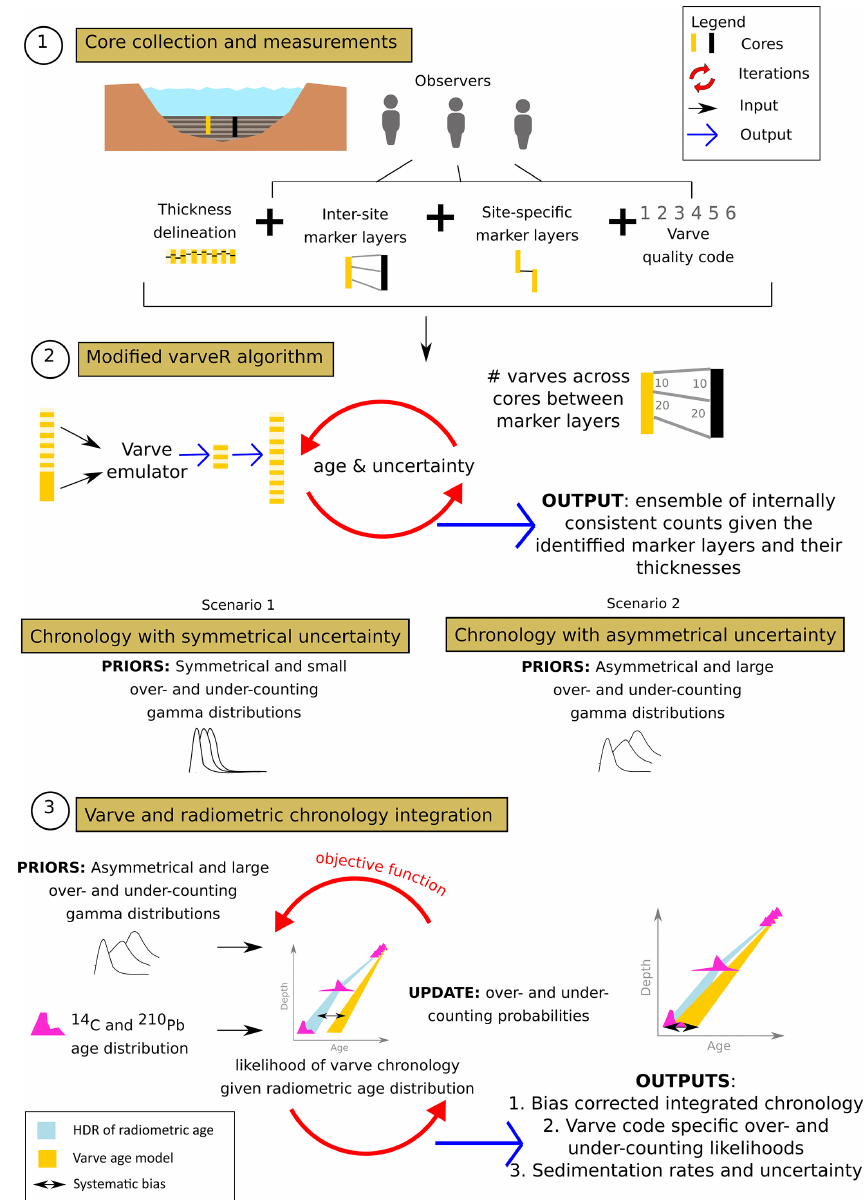
Figure 3. Schematic of the approach used in this study. (1) Gathering raw measurements of lamination thickness, counts, and marker layers for each core and each observer. (2) Using our varve-only model to produce a chronology following scenario 1 (symmetrical and literature-derived likelihoods of over- and under-counting) and scenario 2 (asymmetrical and larger likelihoods of over- and under-counting). (3) Integrating radiometric information into the varve chronology by updating the prior likelihoods of over- and under-counting in an objective function. The posteriors of the n th best function output are used to run an updated varve-only model and produce the final chronology that minimizes systematic bias, quantifies uncertainty related to misidentifying marker layers, observer bias, and lamination quality, and outputs sedimentation rates with